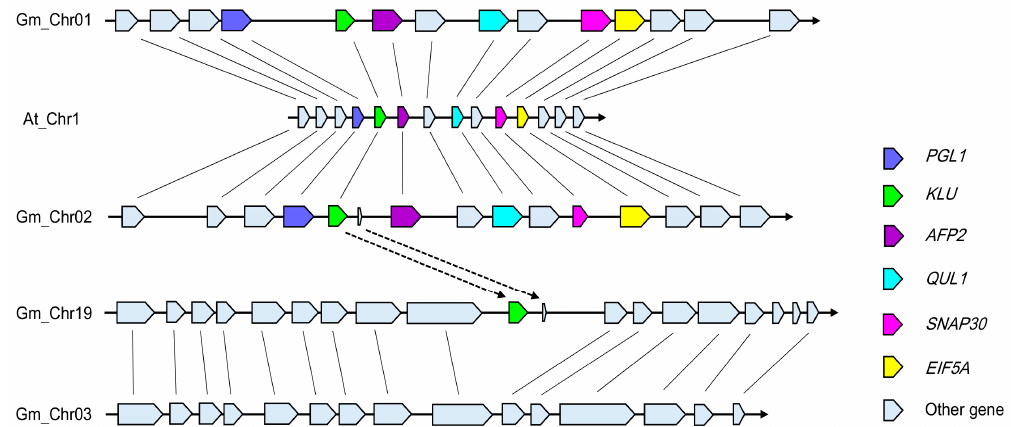
Figure 2. Synteny diagram plot of the soybean and Arabidopsis sequence assemblies surrounding the Arabidopsis KLU gene. The color key for specific genes is as follows: PGL1 (6-phosphogluconolactonase 1, At1G13700)—blue; KLU (cytochrome P450, At1G13710)—green; AFP2 (ABI five binding protein 2, At1G13740)—purple; QUL1 (QUASIMODO2 LIKE 1, At1G13820)—magenta; ANAP30 (Soluble N-ethylmaleimide-sensitive factor adaptor protein 30, At1G13860)—pink; and EIF5A (eukaryotic elongation factor 5A-1, At1G13890)—yellow. The syntenic matching genes in G. max are similarly colored. Solid black lines connect the homologous gene pairs.